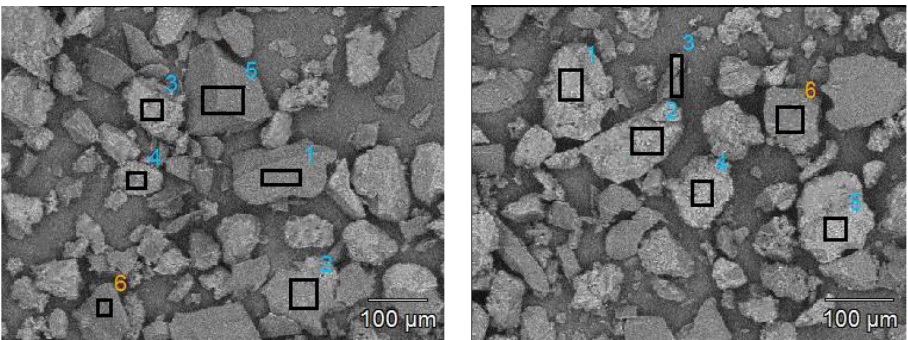
Figure 2. The selection of areas for silicon content measurements (numbers mark the areas selected for analysis).